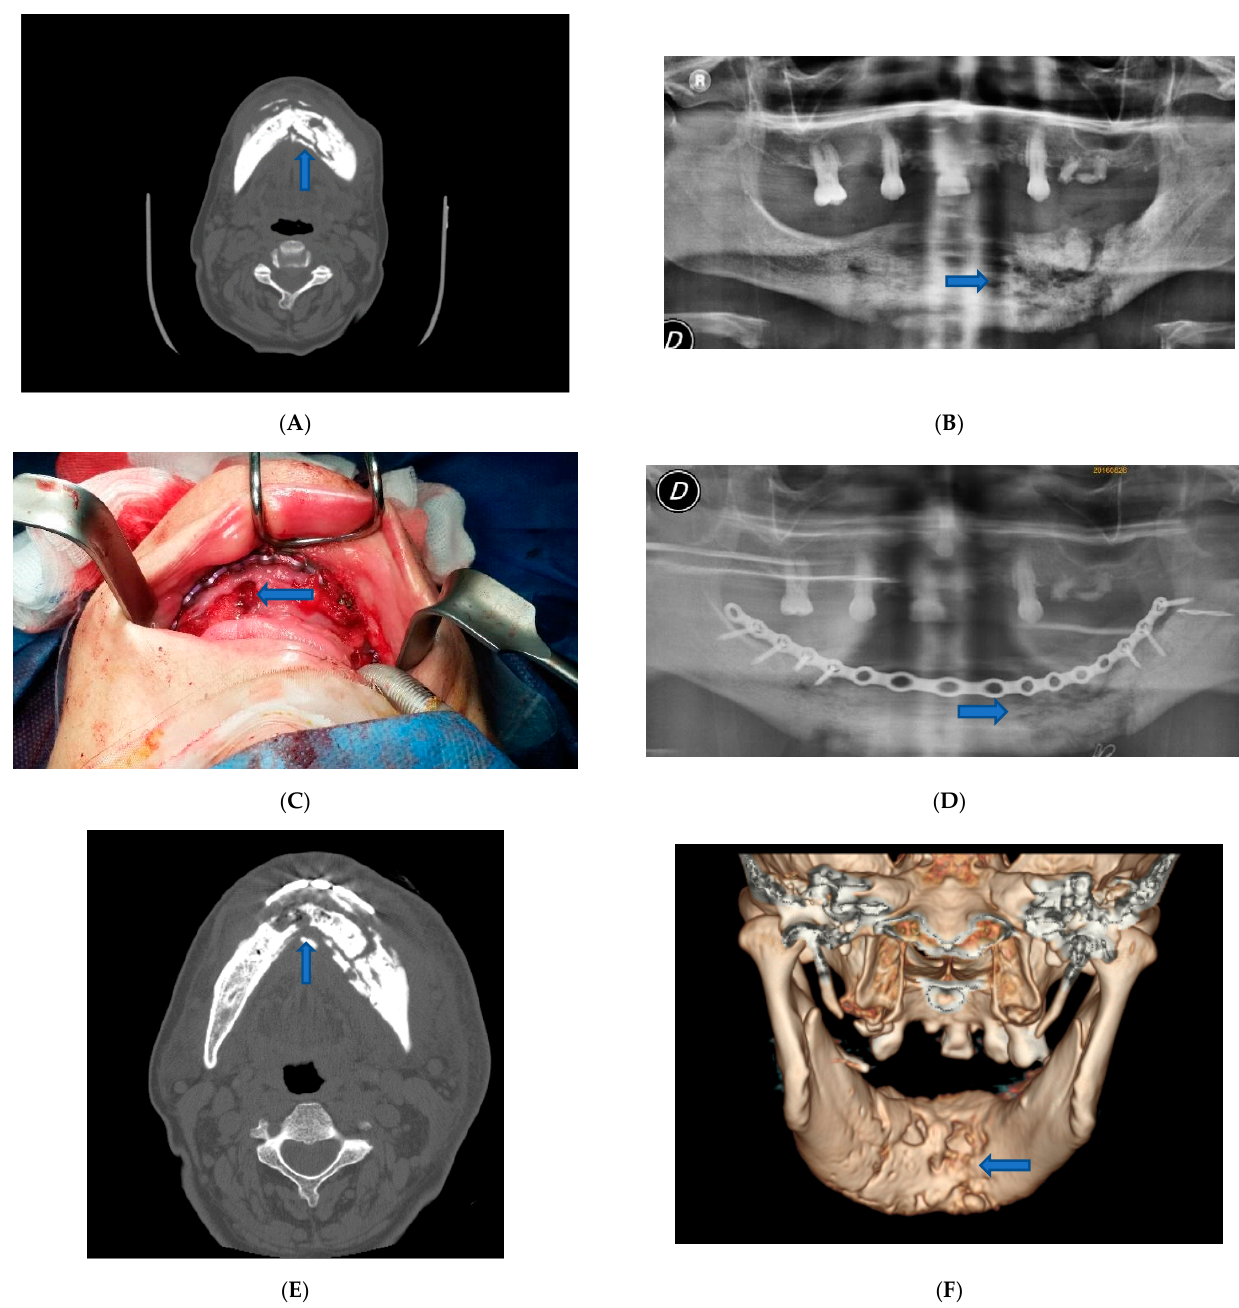
Figure 1. Patient 1. ( A ) Pre-operative CT scan image showed lithic area in the mandibular horizontal branches, which appeared subverted and fractured on the left side. ( B ) Pre-operative panoramic X-ray image of the dental branch revealed lithic area. ( C ) Epi-mucosal fixation performed using SMART Lock screws and plates without elevating the mucoperiosteal flap. ( D ) Post-operative panoramic X-ray image of the dental branch. ( E ) Post-operative CT scan image. ( F ) Post-operative CT scan 3D reconstruction.